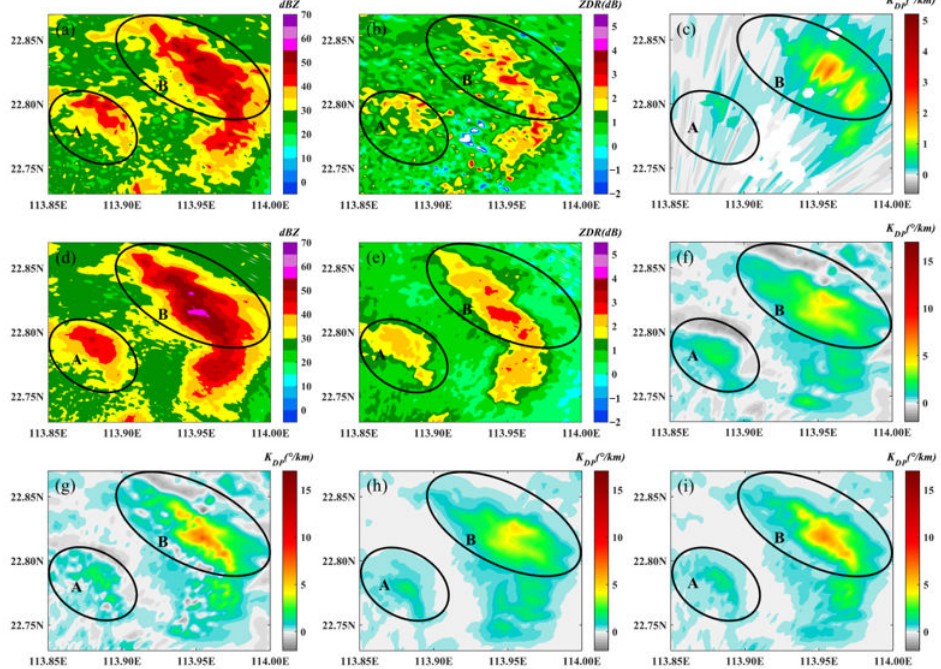
Figure 8. Radar PPI of ( a ) Z H from S-POL, ( b ) Z DR from S-POL, ( c ) K DP from S-POL, ( d ) Z H from X-PAR, ( e ) Z DR from X-PAR, ( f ) K DP from X-PAR calculated by Exp1 (LS without δ -elimination), ( g ) K DP from X-PAR calculated by Exp2 (LS with δ -elimination), ( h ) K DP from X-PAR calculated by Exp3 (LP without δ -elimination), ( i ) K DP from X-PAR calculated by Exp4 (LP with δ